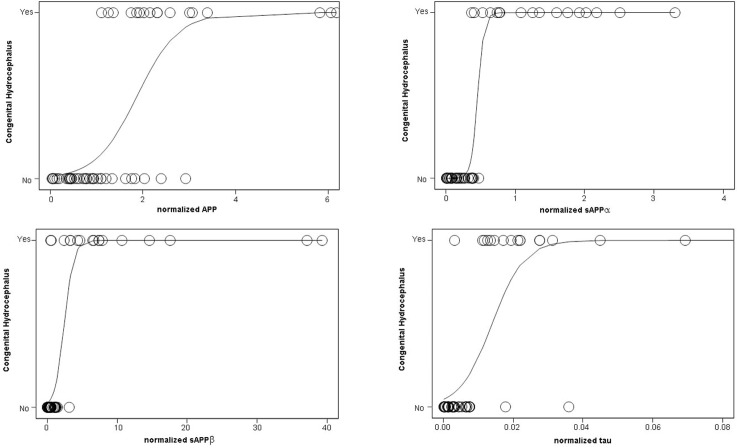
Logistic probability of CSF biomarkers for congenital hydrocephalus.Shown are logistic probability curves of normalized CSF levels of APP, sAPPα, sAPPβ, tau for congenital hydrocephalus (CHC) or no CHC (control and other neurological diseases subjects). Note that sAPPα, followed by sAPPβ, had the highest predictive ability for differentiating CHC.